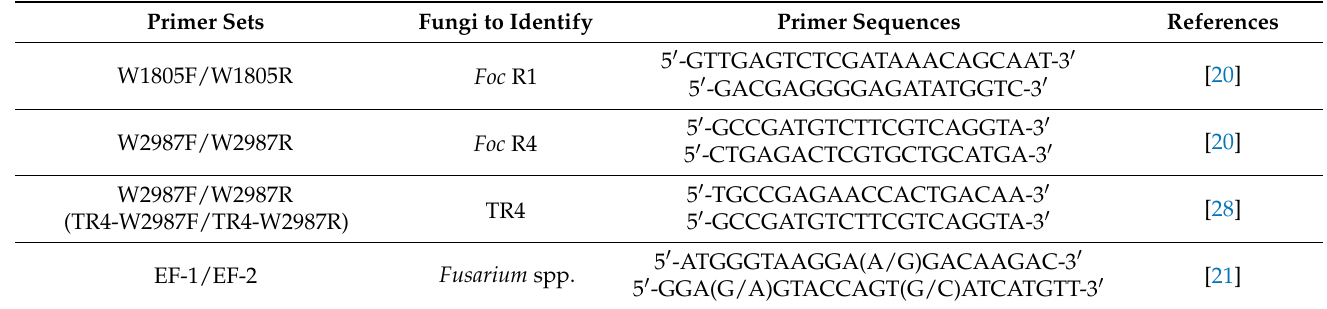
Table 2. The primer sets used to identify the Foc pathogen. Primer Sets